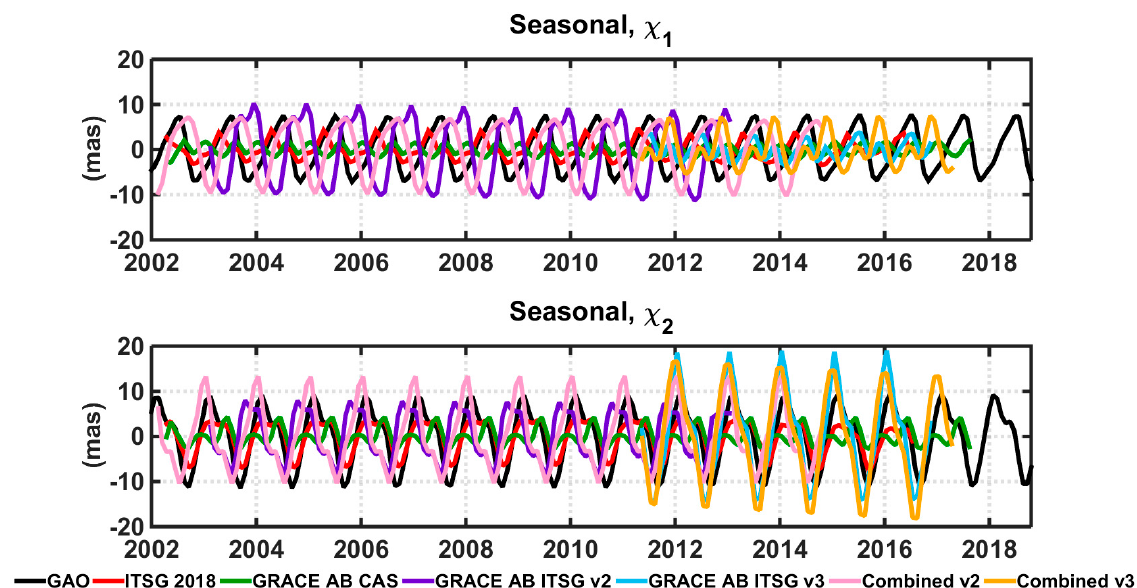
Figure 1. The χ 1 and χ 2 seasonal (sum of annual, semi-annual, and ter-annual) components GAO and HAM obtained from: (1) ITSG 2018 GRACE solution (low-low satellite-to-satellite tracking, ll-SST), (2) solutions based on kinematic orbits of GRACE satellites (high-low satellite-to-satellite tracking, hl-SST), and (3) combined solutions (hl-SST).